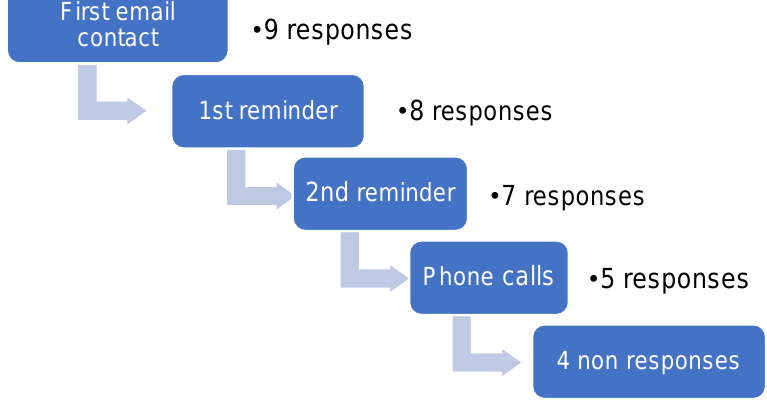
Figure 1. Flow diagram of recruitment.